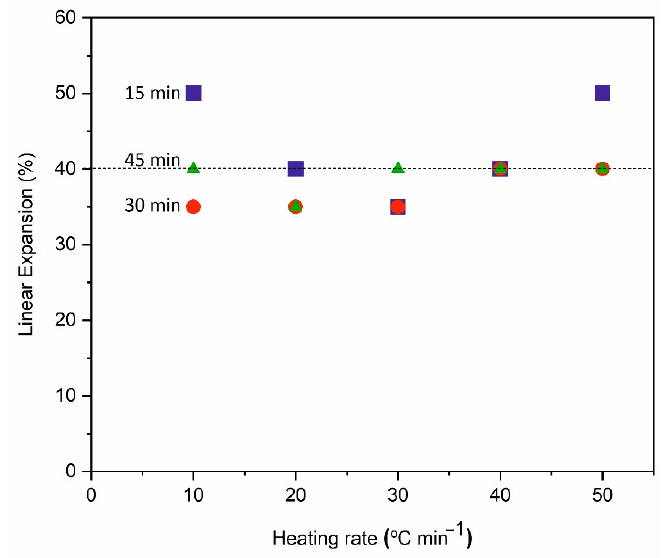
Figure 6. Evolution of linear expansion (LE) with heating rate in pressed pellets of GC–5ES ther- mally treated at 900 °C for 15 min (base glass particle size <1